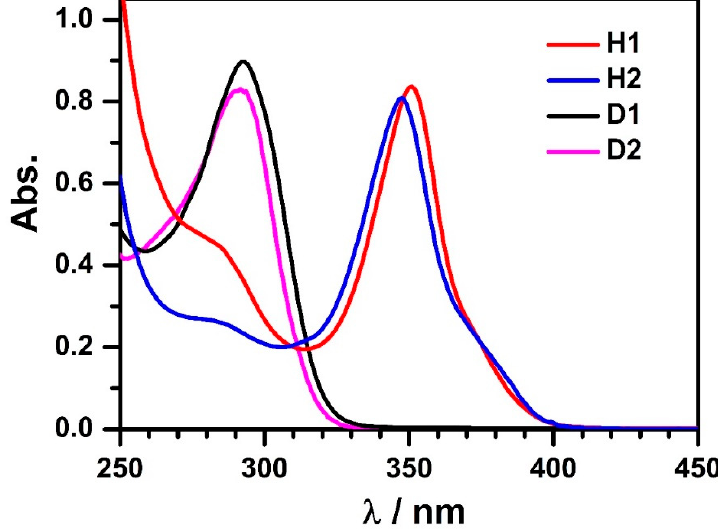
Figure 2. The ultraviolet-visible (UV-Vis) spectra of free hosts ( H1 and H2 ) and guests ( D1 and D2 ) in chloroform solution.